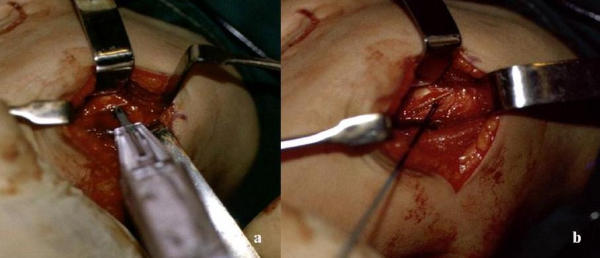
Rigid fixation. Rotator Cuff Quick Anchor which had size 2 with green ethibond polyster sutures on it, was applied at the insertion point of infraspinatus muscle.